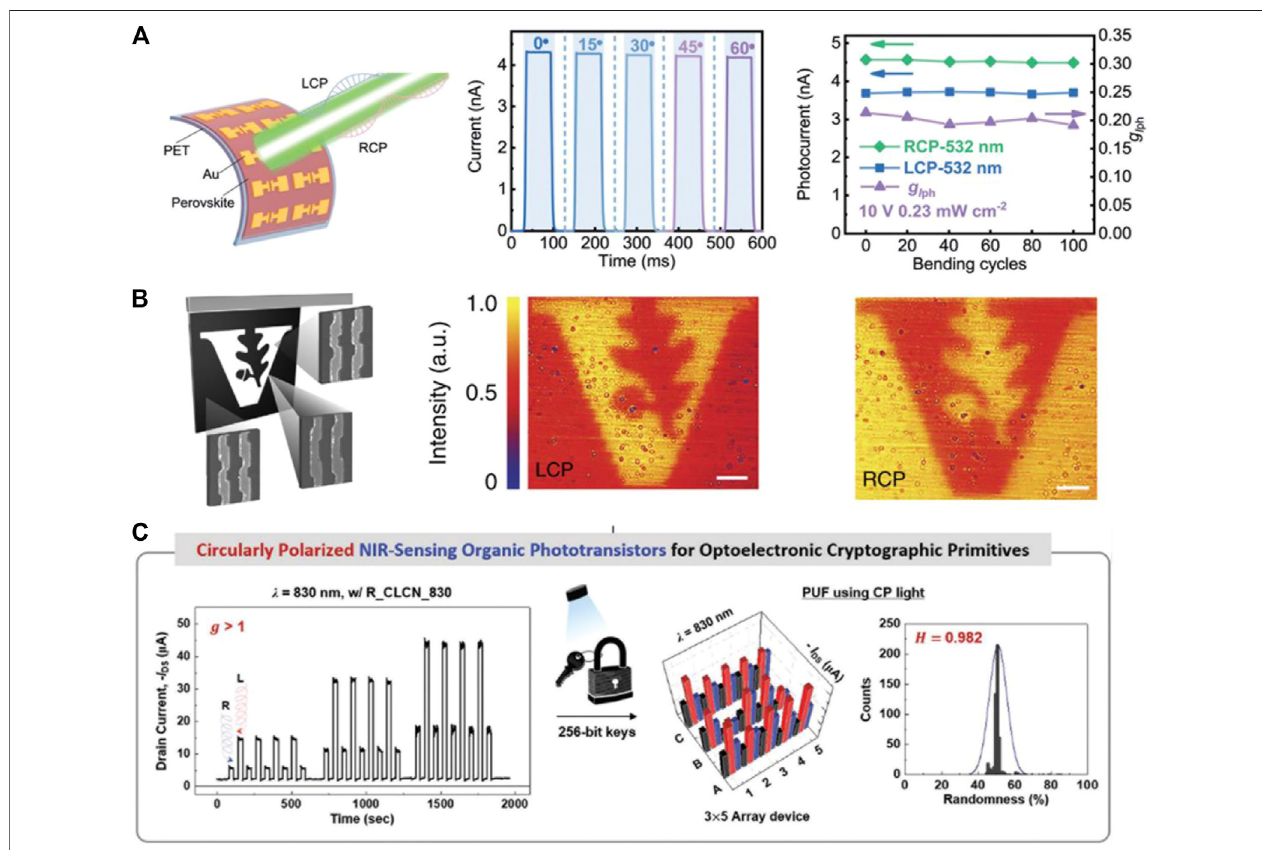
FIGURE 11 | (A) Schematic illustration of a fl exible CPL-sensitive photodetector based on the [(R)- β MPA] 2 MAPb 2 I 7 fi lm, I – t curves at different bending angles (0 ˚ – 60 ° ), and photocurrent and g lph as a function of bending cycles (Wang et al., 2020). Reproduced with permission. Copyright 2020, Wiley-VCH. (B) Schematic of the pattern with the LH metamaterial fi lling the black region and the RH metamaterial fi lling the white region. Photos of the metamaterial under LCP (left) and RCP (right) illumination(Li et al.,2015).Reproduced withpermission. Copyright 2020,NaturePublishingGroup. (C) Circularly polarizedNIR – sensing organic phototransistors for optoelectronic cryptographic primitives (Han et al., 2020). Reproduced with permission. Copyright 2020,